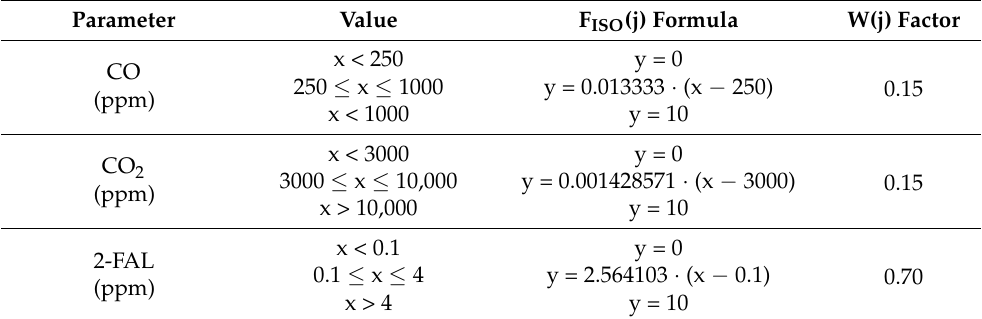
Table 6. The individual formulas and weighting factors used to evaluate the aging of the solid